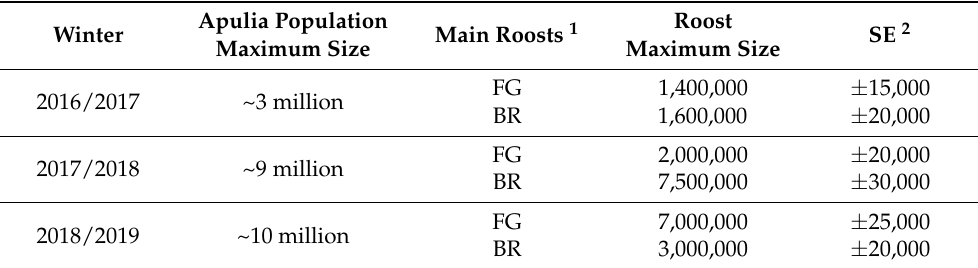
Table 2. An estimate of the population size of wintering starling in Apulia and the main roosts in the three winters of the study. Size